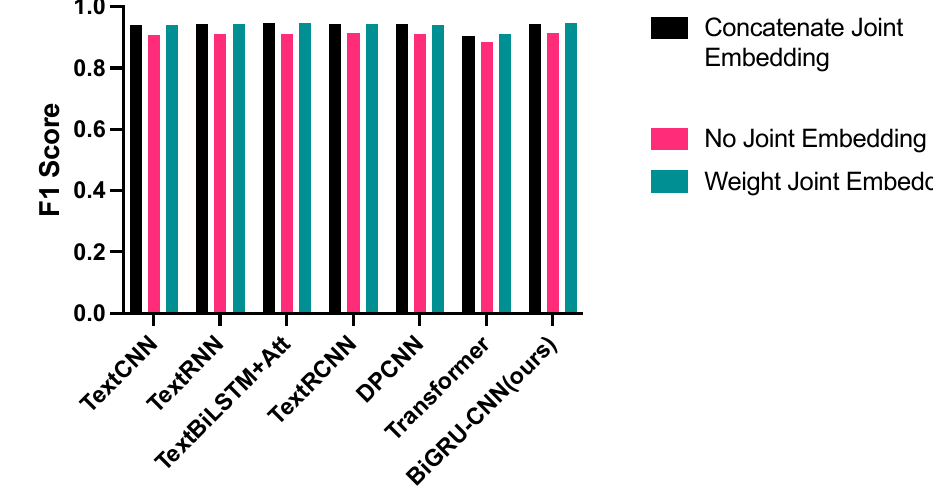
Figure 6. The influence of the joint textual and phonetic embedding on various deep learning